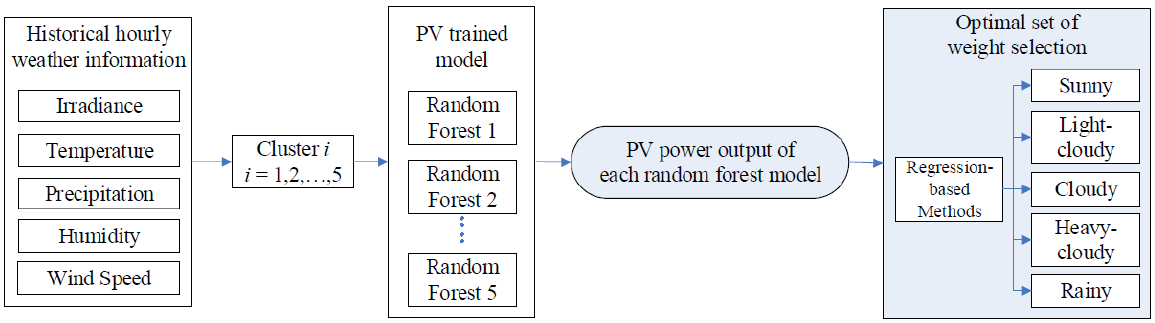
Figure 5. The detailed process of step 2.